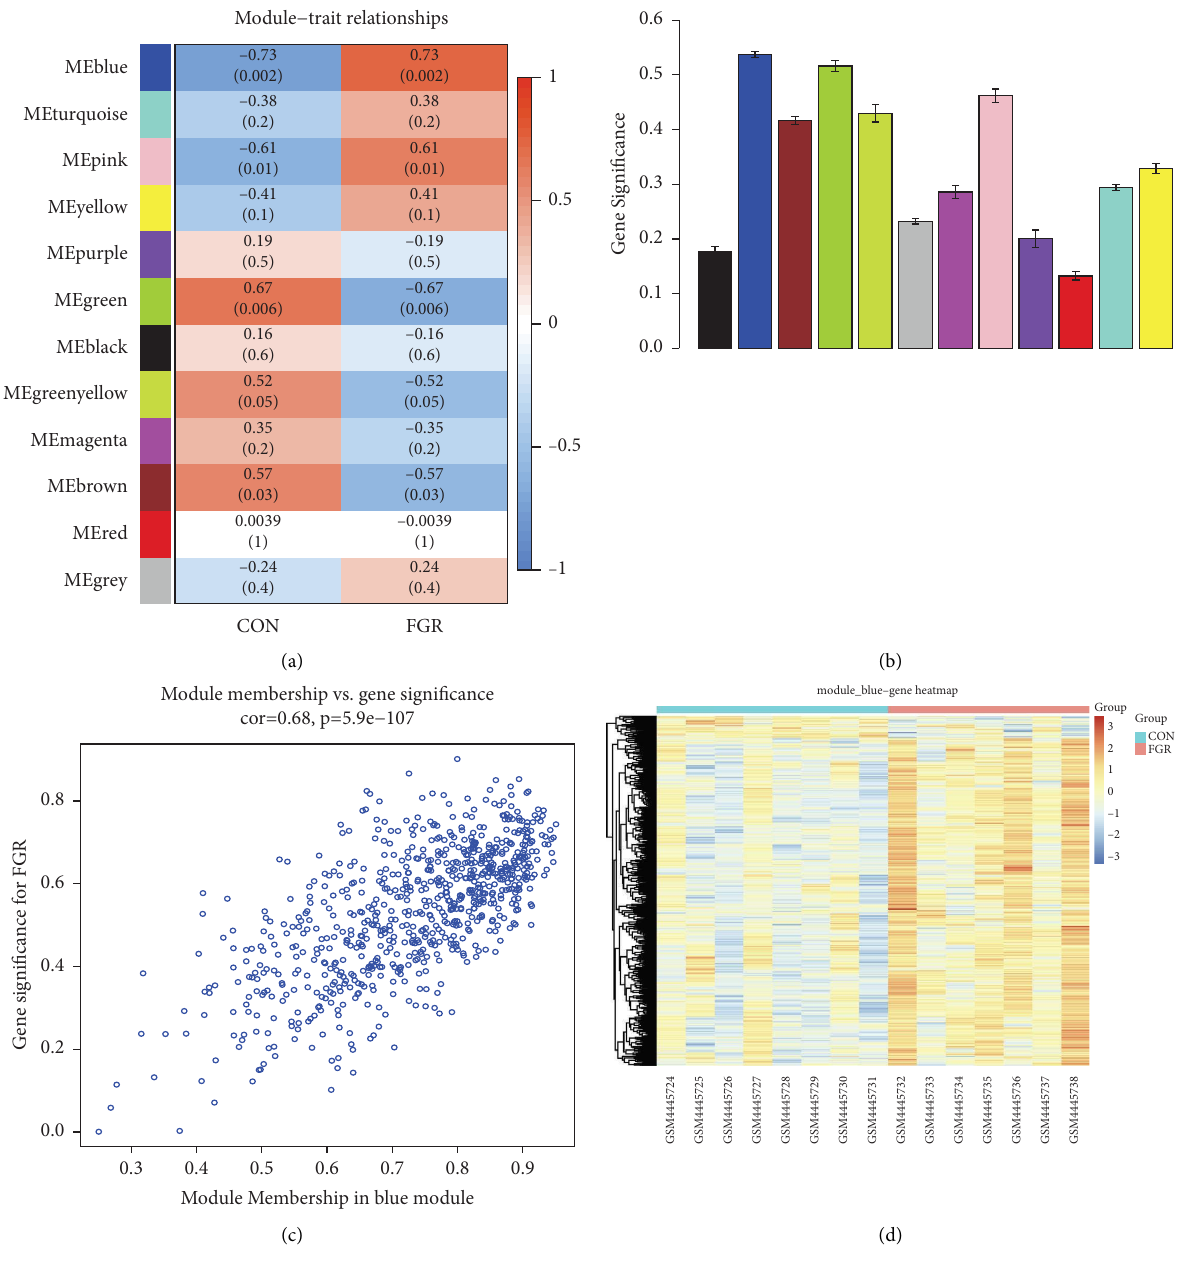
Figure 3: Module-trait correlation analysis. (a) Module-trait relationship heatmap (each cell contains correlation coefcients and cor- responding P values). (b) Module signifcance values of co-expression modules associated with FGR (module signifcance values indicate the summary of gene signifcance of all genes in each module, and diferent colored columns indicate diferent modules). (c) Gene signifcance of FGR in blue modules. (d) Heatmap of genes in the blue